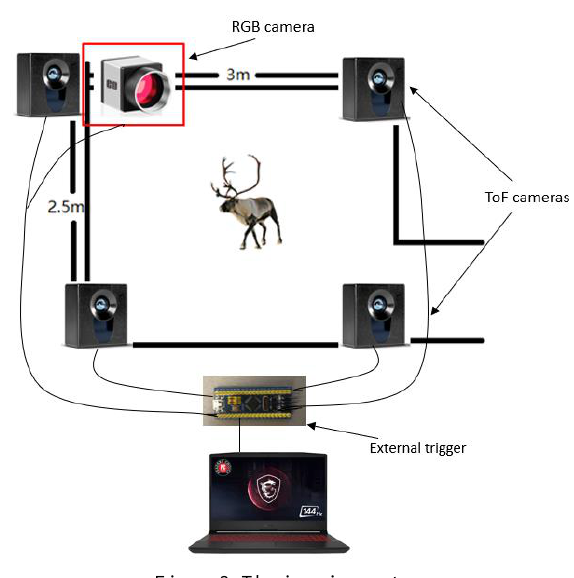
Figure 3. The imaging